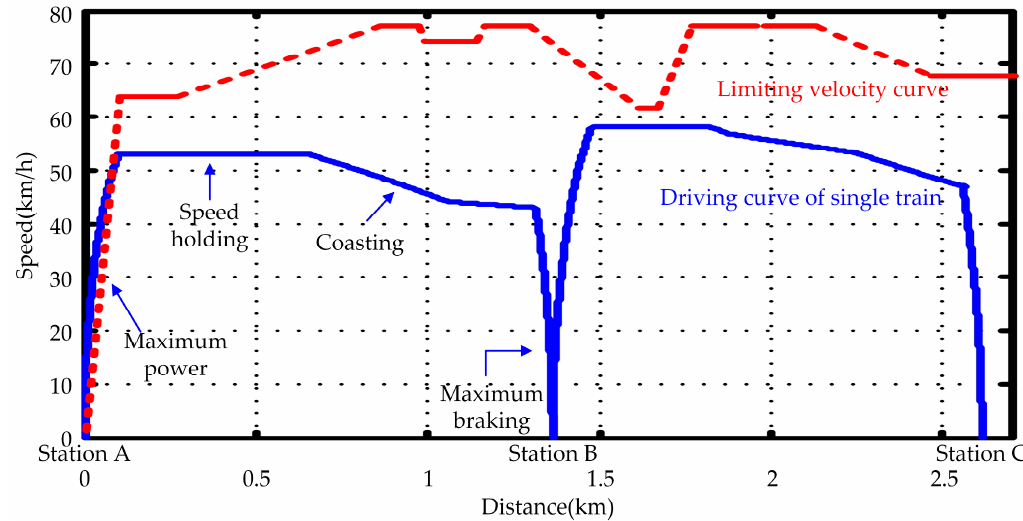
Figure 3. Energy-saving operation curve and limiting velocity curve.